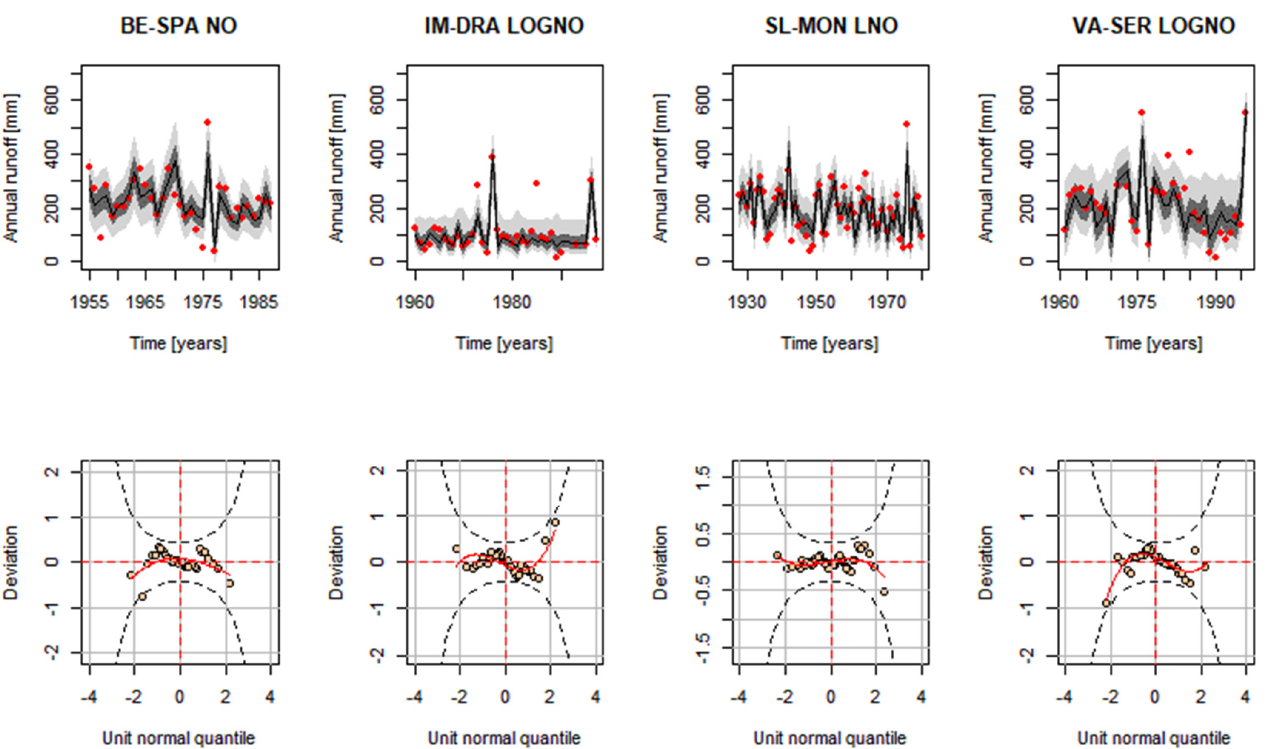
Figure 8. Best suitable distribution centile curves ( first row ) and the corresponding worm plots ( second row ) for the µ ~cs(p), σ ~p model. The legend for the first line is the same as in Figure 5. Table 3. Comparison of the best stationary and non-stationary models with rainfall as covariate. In bold are shown the distributions that provided the lowest AIC values between the analyzed distri- butions for each station.